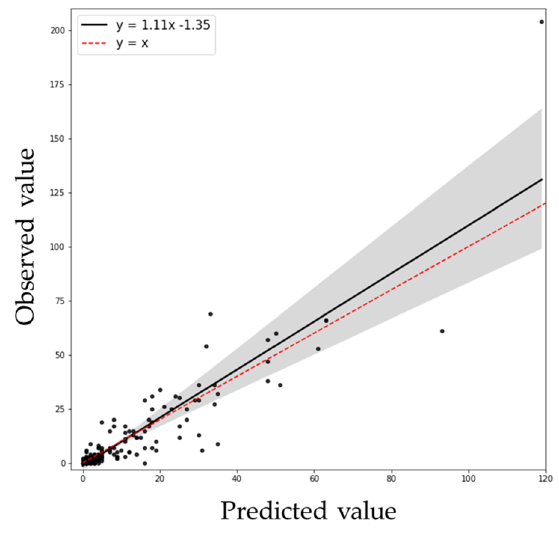
Figure 4. Linear fitting results of test data.